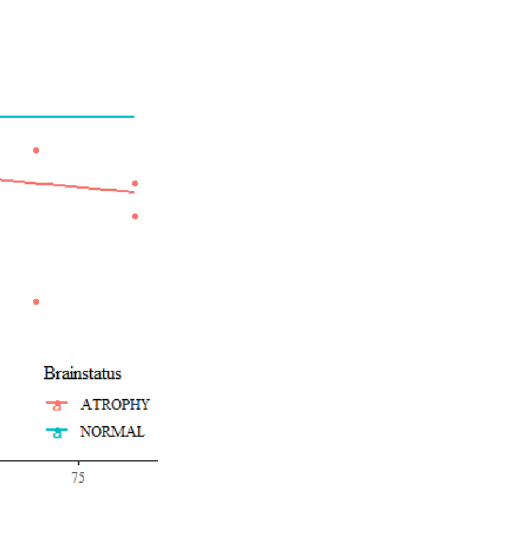
Figure 6. Beta-Alpha Ratio relation to brain